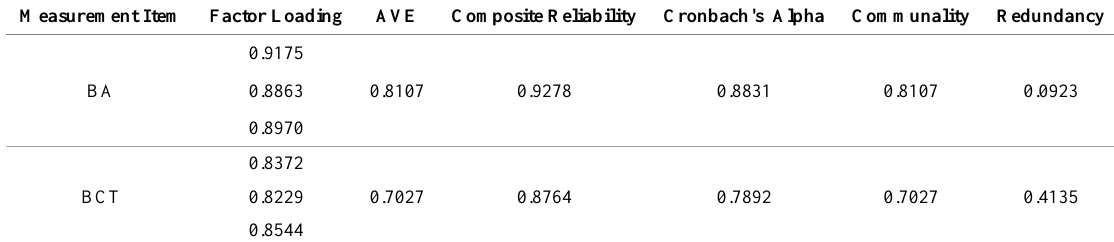
Table 4. Convergent validity and reliability